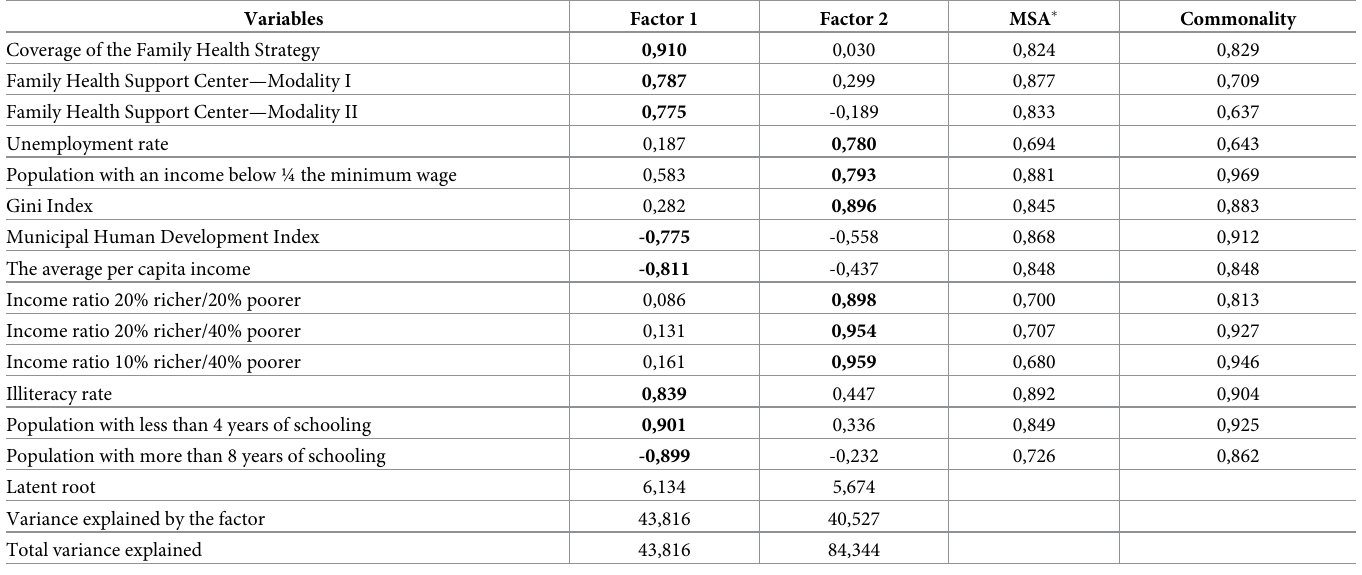
Table 2. Final model of the factor analysis with description of the factor loads, measure of sample adequacy, and commonality of the included variables, and latent root, percentage of explained and accumulated variance of each extracted factor. Brazil,